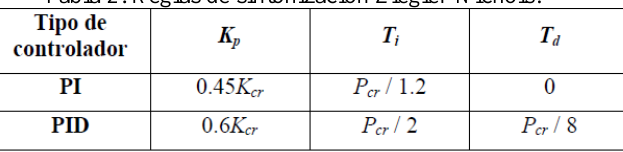
Tabla 2: Reglas de sintonización Ziegler-Nichols.